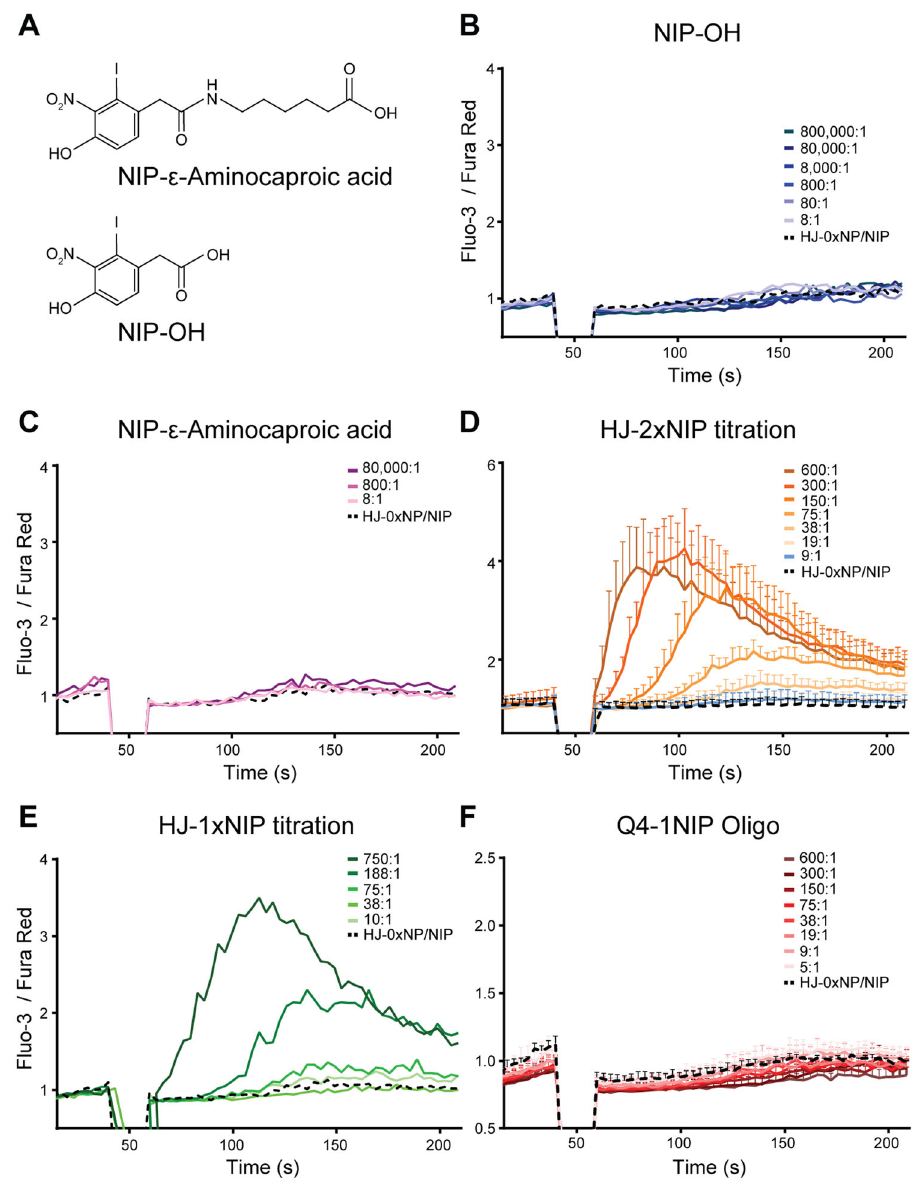
Fig. 6 | Activation of B1-8i B cells with small-molecule haptens versus HJ constructs. A Chemical structure of NIP- ε -Aminocaproic acid and NIP-OH. B Calcium fl ux of cells upon stimulation with NIP-OH at varying molar stoichio- metries from 800,000-fold molar excess of antigen to BCR, down to 8:1 stoichio- metry. C Calcium fl ux of cells upon stimulation with NIP- ε -aminocaproic acid at varying molar stoichiometries from 80,000-fold molar excess down to 8:1 stoi- chiometry. D Calcium fl uxof cellsupon stimulation with HJ-2xNIP atvarying molar stoichiometries from 600-fold molar excess of HJ to BCR down to 9:1 stoichio- metry. E Calcium fl ux of cells upon stimulation with HJ-1xNIP at varying